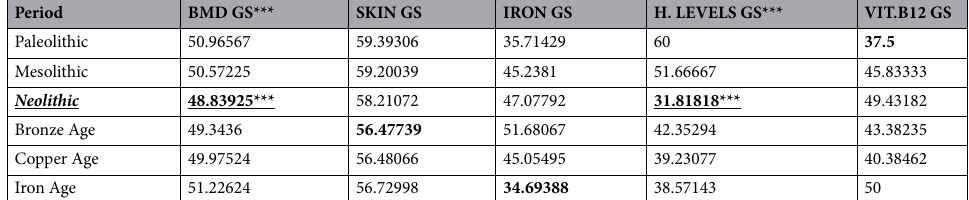
Table 2. Genetic risk score for the different phenotypes tested here: bone mineral density, skin pigmentation, iron metabolism, haemoglobin levels and vitamin B12 metabolism. In bold script, the lowest value in each phenotype. *** marks the phenotypes where the lowest values coincide with the Neolithic (bone mineral density and haemoglobin levels).